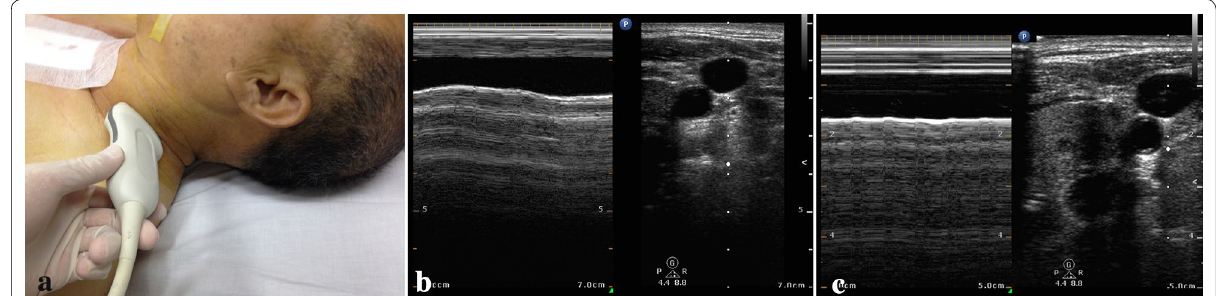
Fig. 1 Ultrasound probe position for IJV detection at the cricoid cartilage level ( a ). The patient is in the supine position at 30°. M‑mode assessment of the antero‑posterior diameter of the IJV in a responsive patient ( b , a high variability of IJV diameter is seen) and in a non‑responsive patient ( c , lack of variation of the IJV diameter is seen) while on mechanical